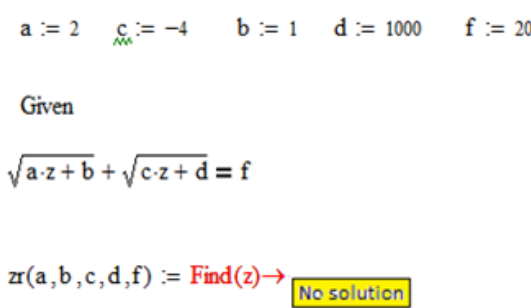
Figure 4. Listing of the program for the numerical solution of Equation (1).